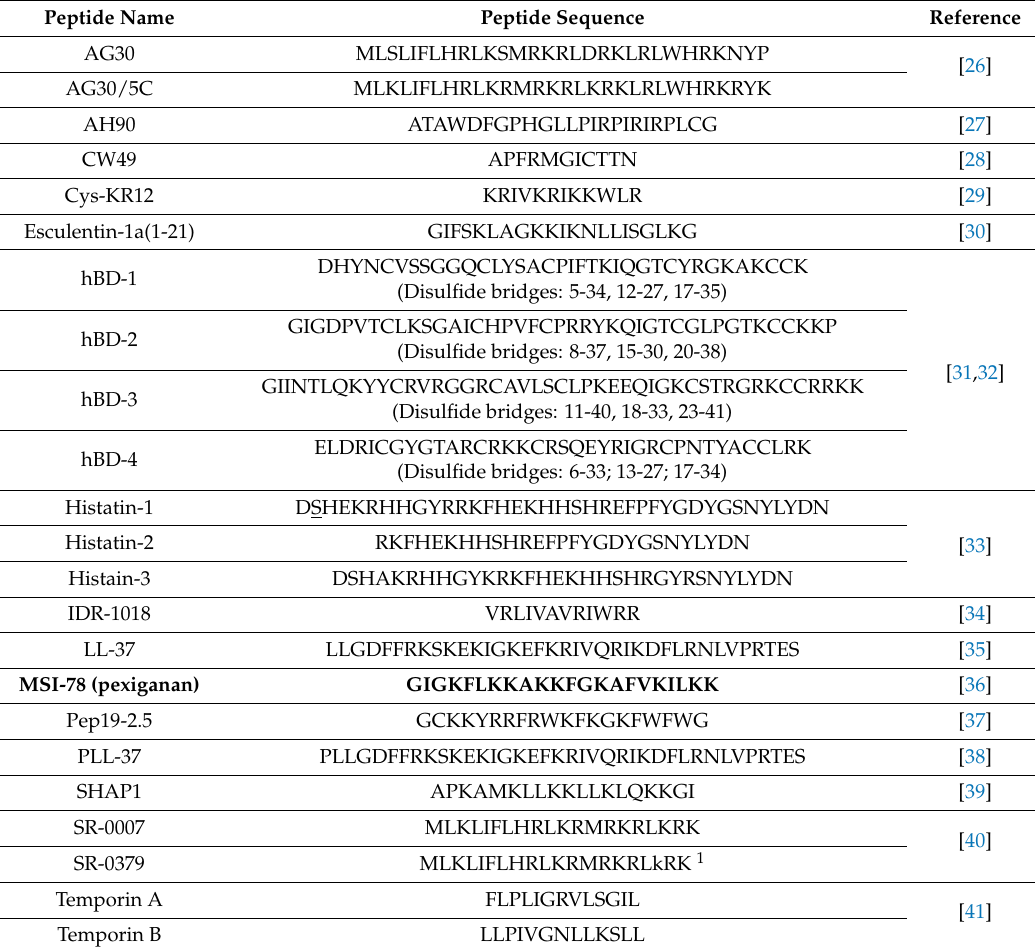
Table 1. Examples of peptides with dual antimicrobial and wound-healing properties. Peptide sequences are displayed using the one-letter amino acid code, as per the IUPAC-IUBMB Joint Commission on Biochemical Nomenclature